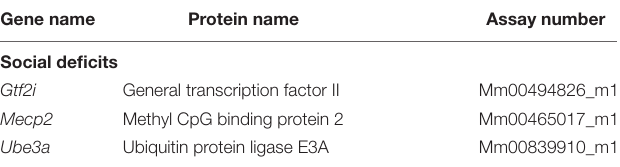
Frontiers in Behavioral Neuroscience |